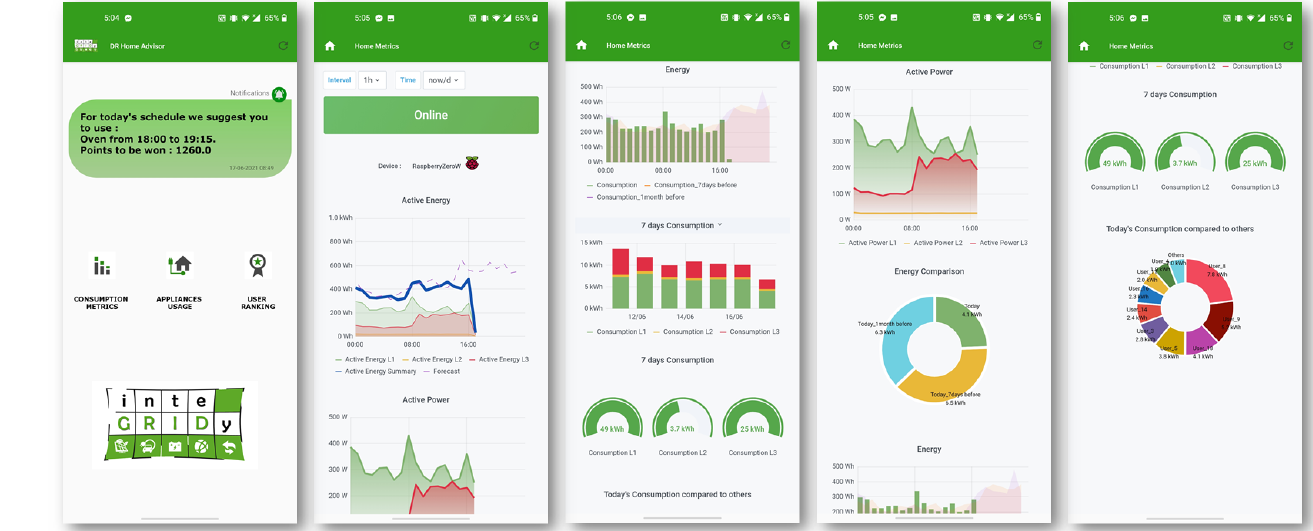
Figure 4. ODRes Mobile Application for Android